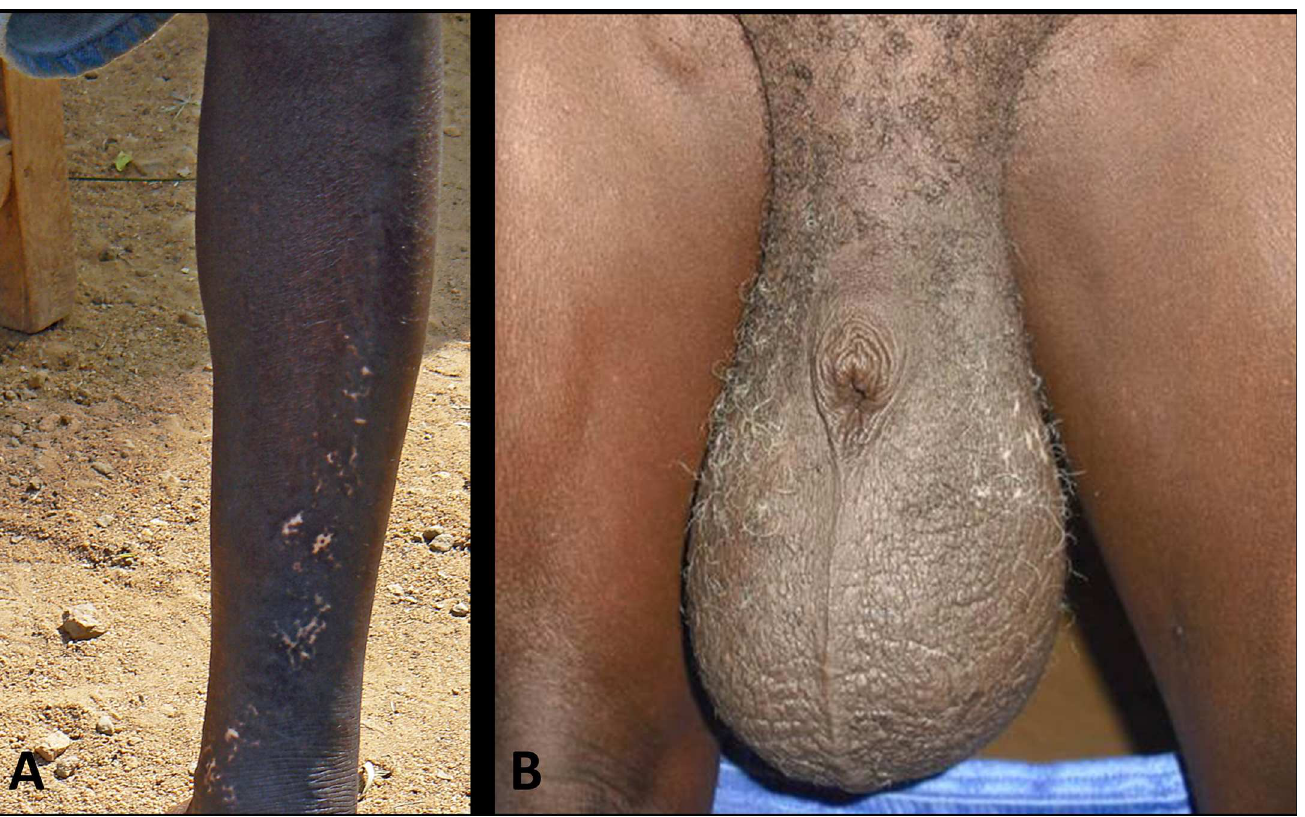
Fig 1. Clinicalsigns of onchocerciasis ( A ) and lymphatic filariasis( B ) in the same individualliving in an area coendemicfor both infectionsin Lofa County, Liberia. A Hypopigmented skin (“leopardskin”) on the shins. B Advancedhydrocele.